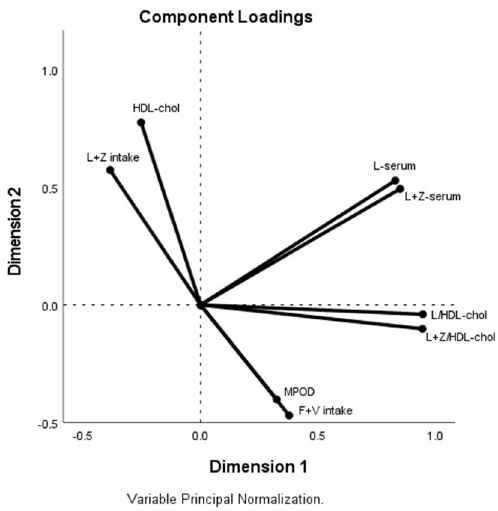
Figure 3. Factor analysis loading plot. Two principal components. MPOD, fruit and vegetable groups, lutein+zeaxanthin intake, serum lutein, lutein+zeaxanthin, lutein/HDL-cholesterol, lutein+zeaxanthin/HDL-cholesterol and HDL-cholesterol concentrations at the end of the study. Finally, the carotenoid concentrations in the faeces are shown in Table 5. These carotenoids quantified in faeces were lutein, zeaxanthin, β -cryptoxanthin, α -carotene, β -carotene and lycopene. At baseline, the highest concentration in faeces corresponded to β -carotene, followed by lycopene and lutein, and corresponded to the ones consumed in the greatest amounts by participants (Table S1). At lower concentrations were zeaxanthin, α -carotene and β -cryptoxanthin. Differences in faecal lutein concentration were only found between the baseline and final values of the study in the total sample ( p = 0.012) and in the vegetable group ( p = 0.056), but not in the fruit group. No differences were found for any of the other carotenoids analysed in the faecal samples. Considering the two intervention groups, there were differences, at the end of the study, in the concentrations of β -cryptoxanthin ( p = 0.027), α -carotene ( p < 0.001) and lycopene ( p = 0.001 and also at baseline: p = 0.004). Figure 4 shows lutein and zeaxanthin concentrations in the faeces at the beginning and end of the study in each group. Only two of the carotenoids analysed in faeces, lycopene and β -cryptoxanthin, showed significant correlation with their respective dietary intakes, lycopene at baseline and at the end of the study (rho = 0.578, p = 0.001) and β -cryp-